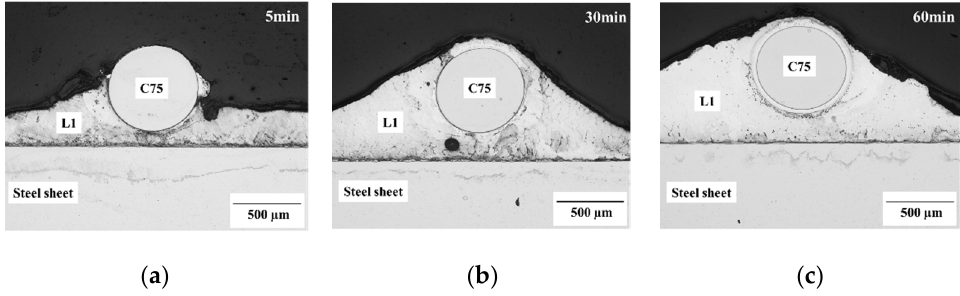
Figure 9. Light microscopy images of brazed steel sheet–L1–Zn coated C75 TWS joints with ( a ) 5 min, ( b ) 30 min, and ( c ) 60 min Zn electroplating time.